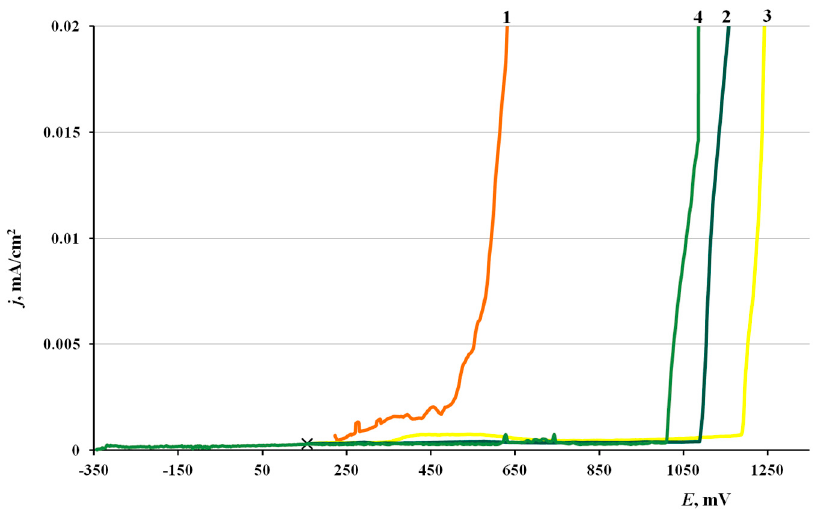
Figure 1. Polarization curves of copper in borate buffer (pH 7.36) +0.001 M NaCl. (1) No treatment with a CIN, (2) BTA, (3) ODA and (4) ODA + BTA.